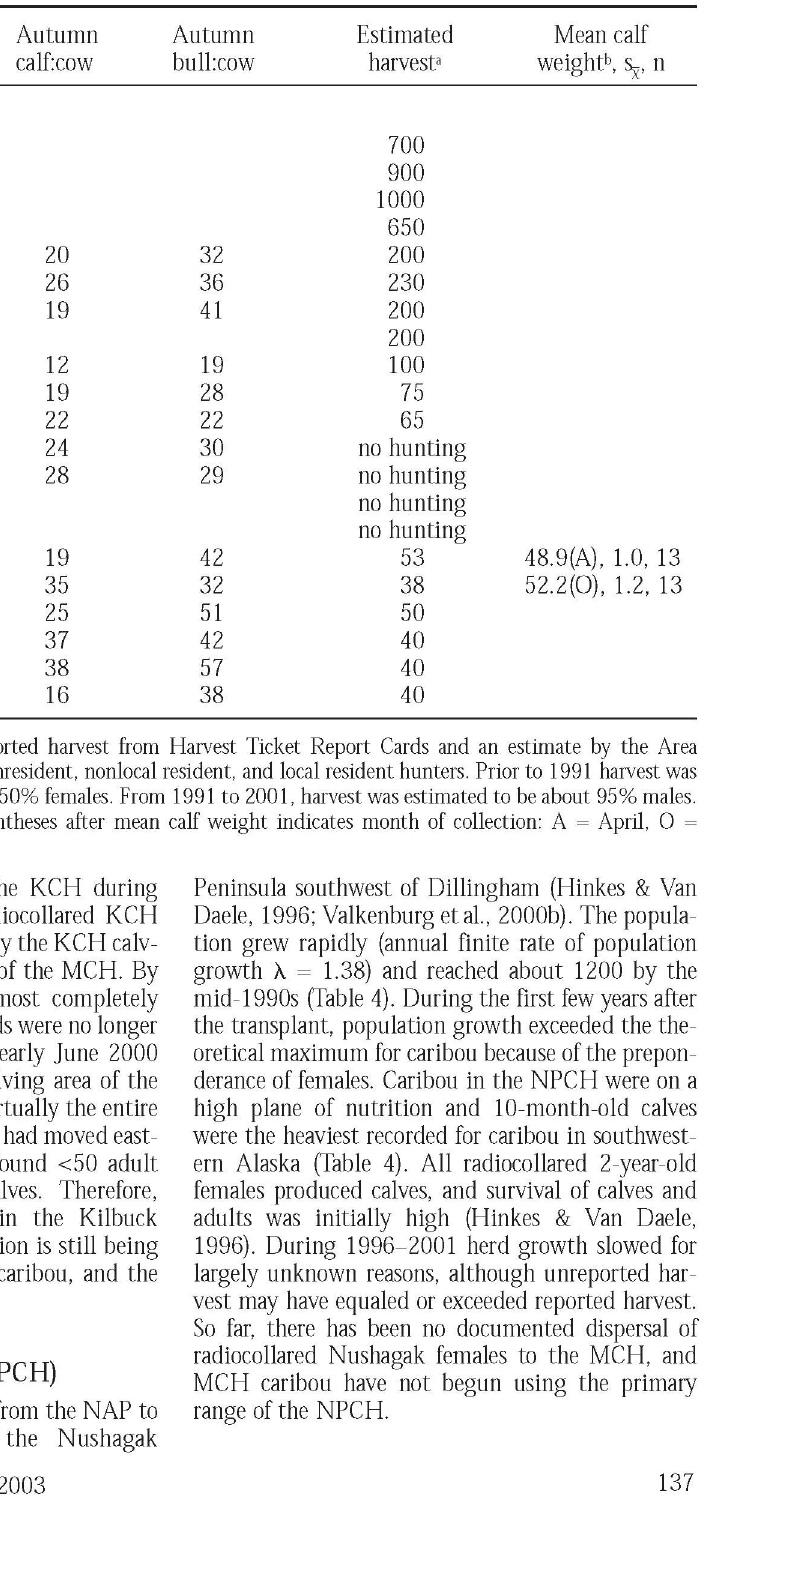
Table 3. Estimates of herd size, fall calfxow ratio, and calf weight in the Southern Alaska Peninsula Caribou Herd, 1975-2002. Year Estimate of Autumn Autumn Estimated Mean calf herd size calf:cow bull:cow harvest a weight b , s^,